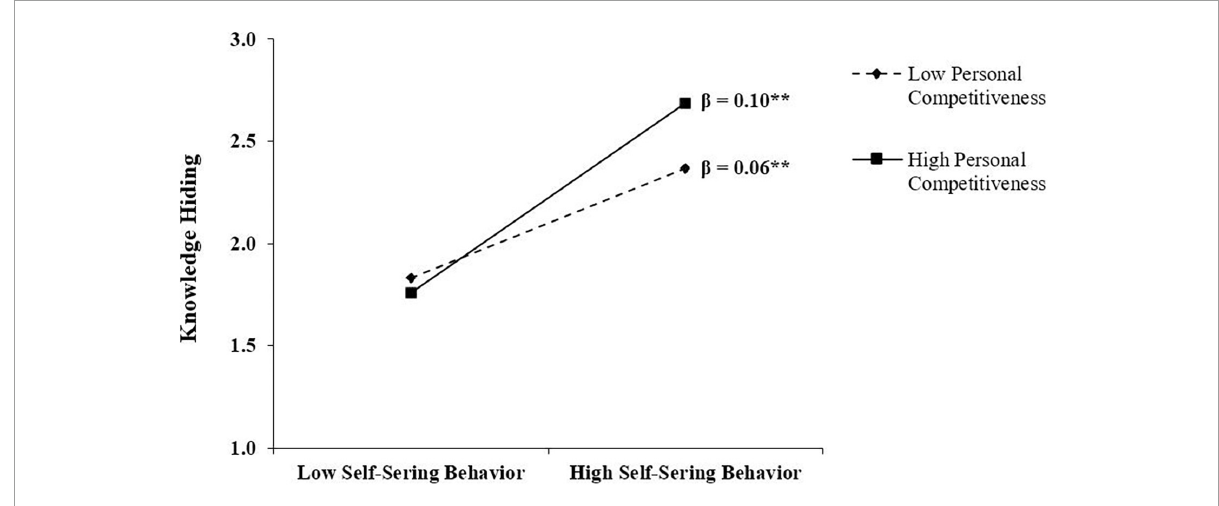
FIGURE2 The moderating effect. Figure represents the moderating effect of personal competitiveness on the relationship between employees’ self-serving behavior and knowledge